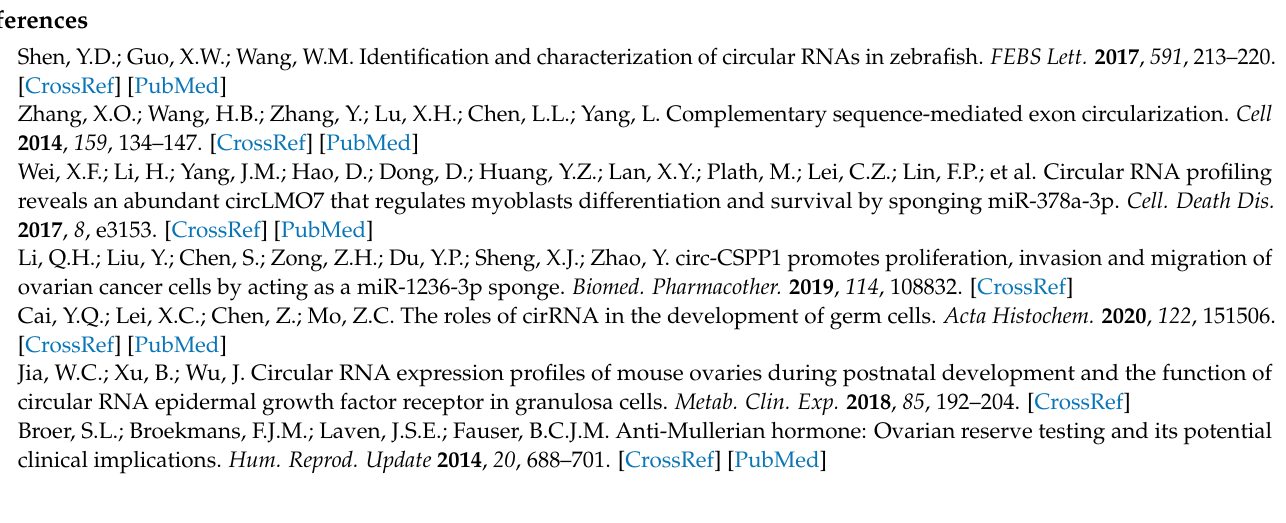
stages. Figure S2: Comparison between qRT-PCR validation results and RNA-Seq data. Figure S3: Coefficient analysis of fold-change data from qRT-PCR and RNA-seq. Table S1: Nucleotide sequences of primers used for PCR amplification of circRNAs. Table S2: qRT-PCR primers of circRNAs. Table S3: Summary of circRNA sequencing